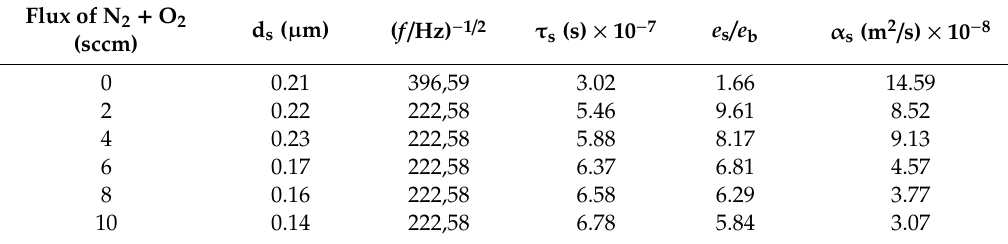
Table 2. Thermal parameters of the samples determined by MIRR, from the data in Figure 8. Thermal di ff usivity ( τ s = d s2 / α s ) values were calculated assuming the thickness ( d s ) estimated by SEM.